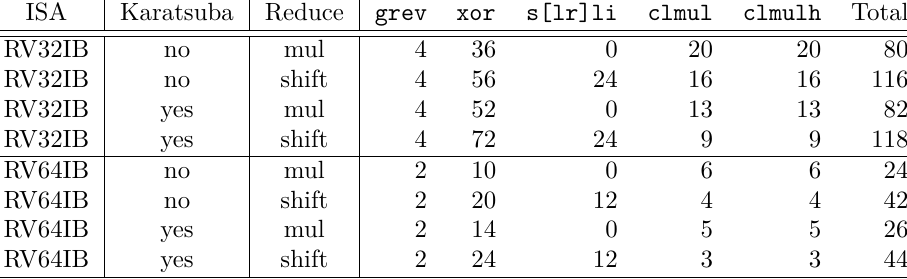
Table 6: Instruction counts for multiplication in F